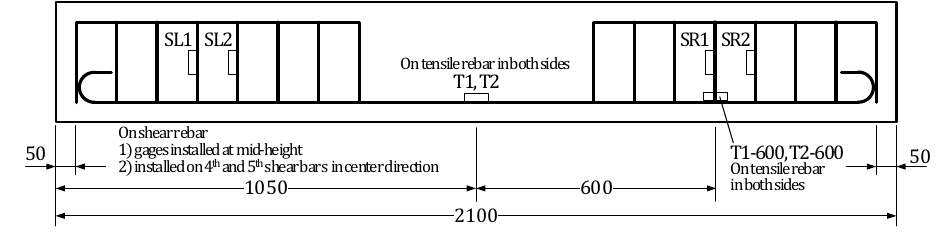
Figure 4. Layout of reinforcement strain gages in test members.